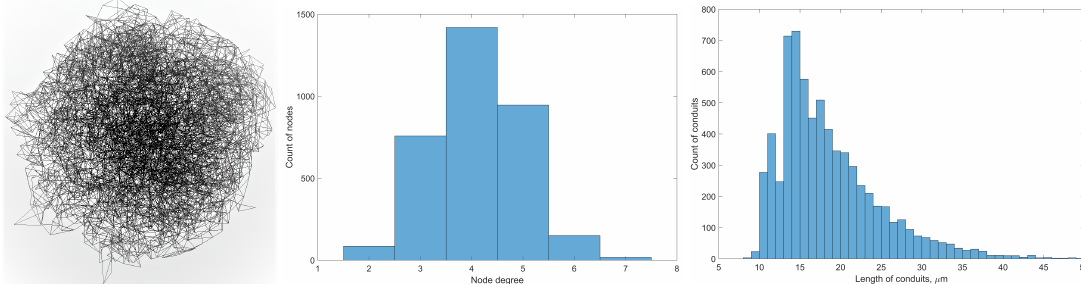
Figure 5. FRC network. ( left ) Network graph; ( center ) Node degree distribution; ( right ) Edges lengths distribution.